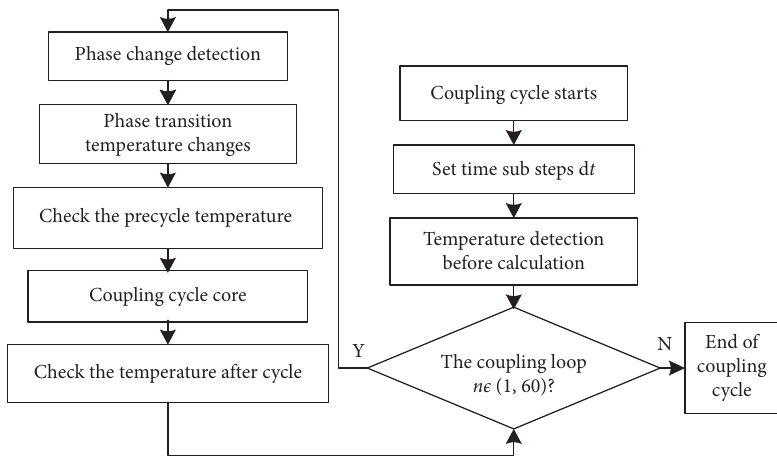
Figure 2: Chart of coupling cycle.